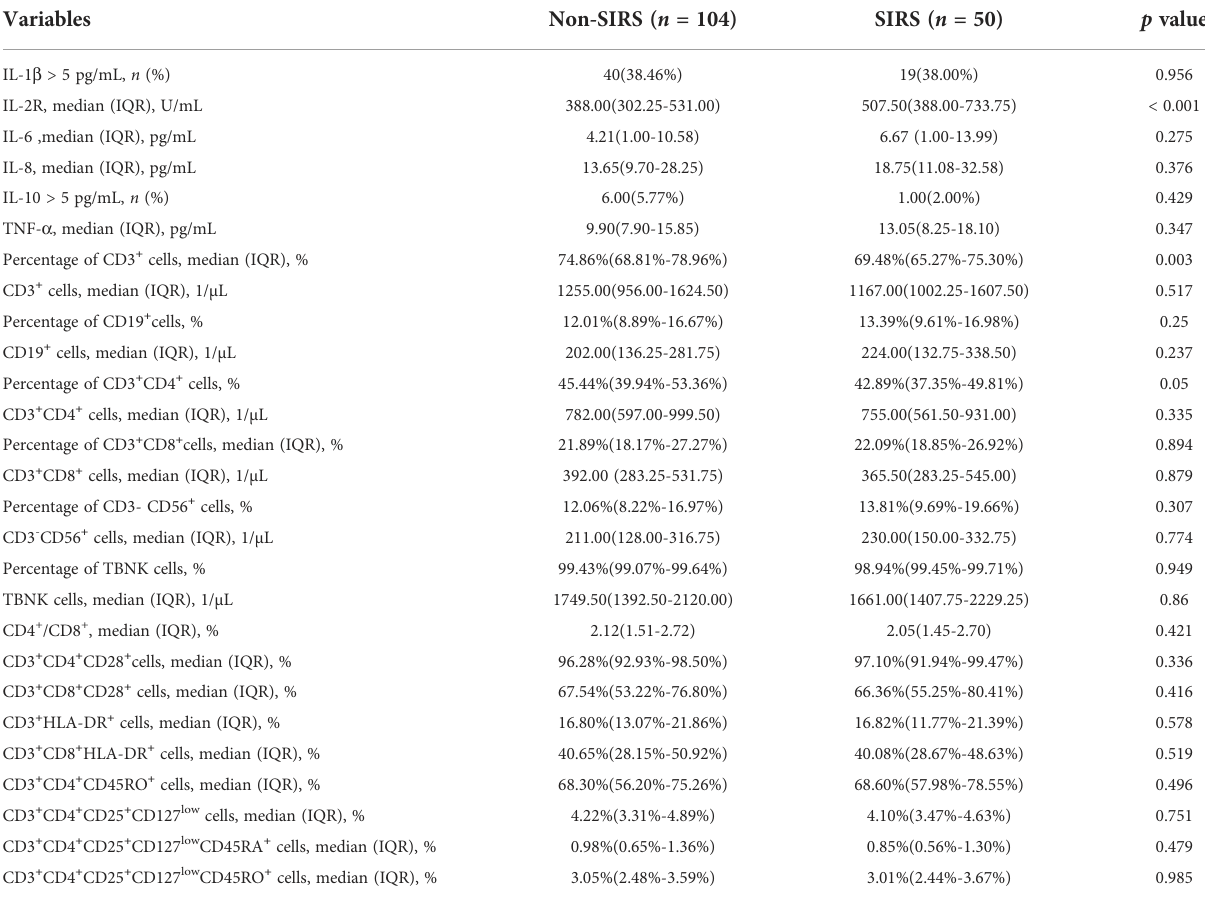
TABLE 2 Cytokine and lymphocyte subsets in the SIRS group and the non-SIRS